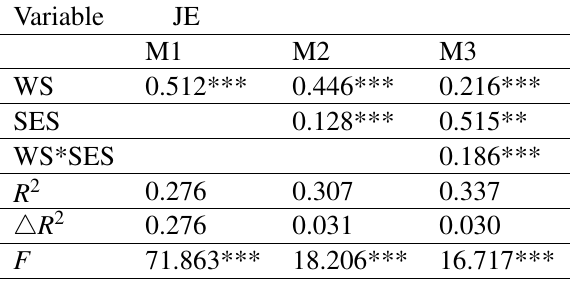
Table 9 The moderating effect of POS (SES)